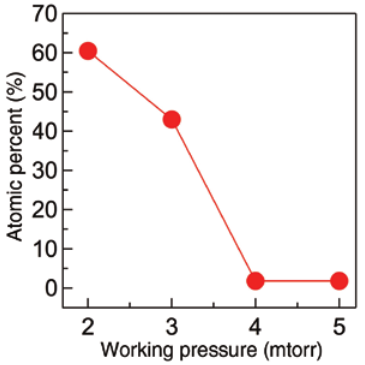
FIgure 5: Atomic percent of Se in Mo films after selenization at 500 ° C for 20 min as a function of working